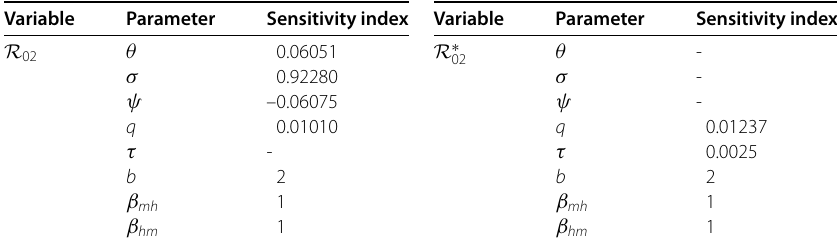
to the parameter values for model (1) 02